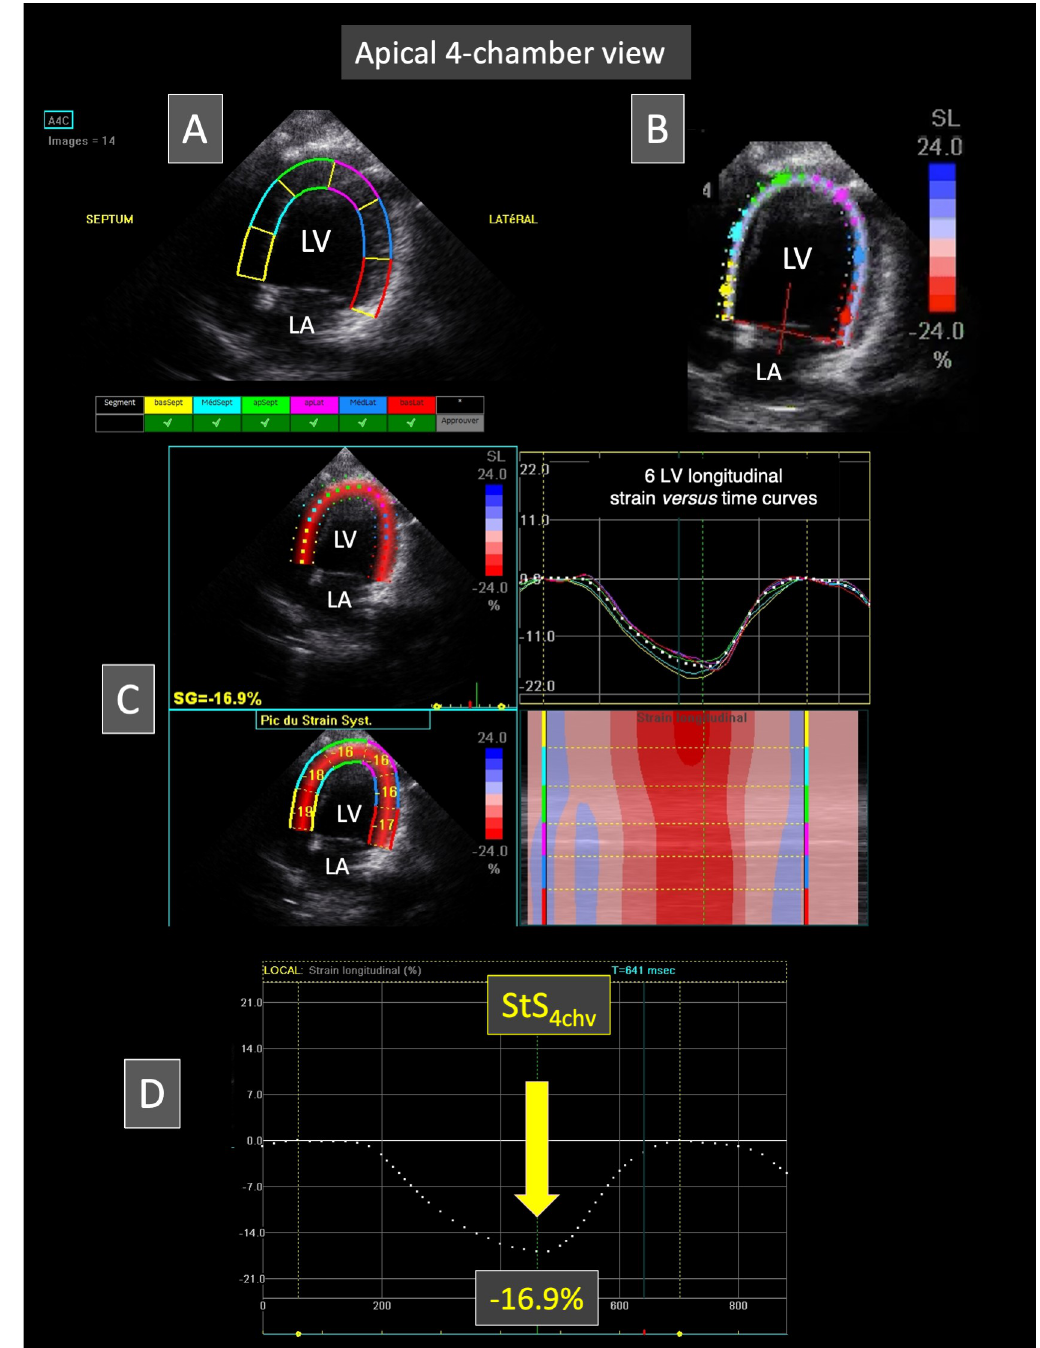
Fig 3. Representative speckle tracking imaging examination performed from the apical 4-chamber view in a Borneo orangutan. The left ventricular endocardial border is traced and a region of interest including left ventricular myocardial walls is automatically drawn (A). The software algorithm then automatically separates left ventricular myocardial walls into 6 equidistant segments (A and B). The tracking quality is displayed for each segment (A). Fig C shows on the right the 6 left ventricular longitudinal strain versus time curves (corresponding to the 6 myocardial segments) during a single cardiac cycle. This representative case demonstrates that all the 6 LV segments undergo a relatively homogenous systolic myocardial shortening during systole (negative strain). The corresponding color map below displays the change in strain over time in each segment during the same single cardiac cycle. The peak systolic strain is displayed in each of the six segments on the two- dimensional color-coded view (left). Fig D shows the mean left ventricular longitudinal strain versus time curve. In this case, the peak systolic strain value (StS 4chv ) is—16.9%. LA : left atrium; LV : left ventricle . https://doi.org/10.1371/journal.pone.0254306.g003 PLOS ONE | https://doi.org/10.1371/journal.pone.0254306 January 24,